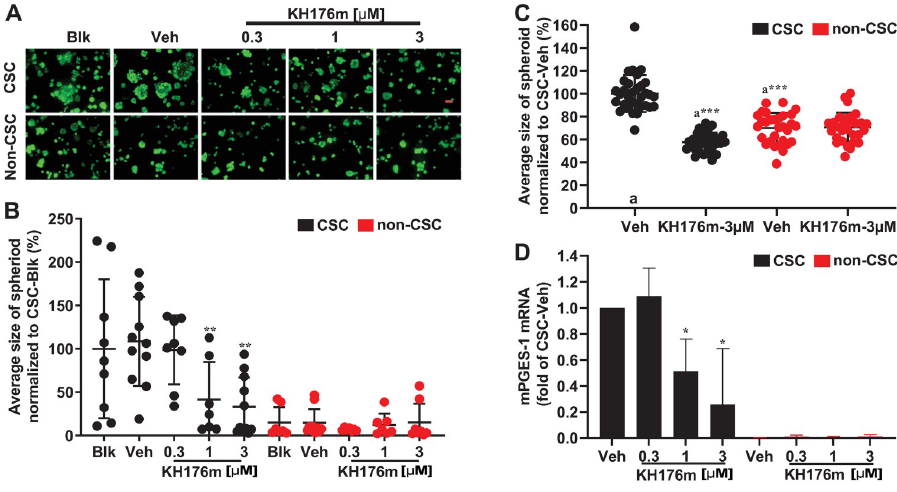
Fig 5. KH176m selectively inhibits mPGES-1 and spheroid growth in prostate cancer stem cells. CSCs or non- CSCs subpopulation were isolated from DU145 human prostate cancer cells based on the cancer stem cell markers CD44-PE and CD24-APC. Both CSCs and non-CSCs subpopulation were grown in Matrigel to induce spheroid formation and treated with vehicle (0.1% DMSO) or various concentrations of KH176m (A) Representative images of spheroids generated by CSCs or non-CSCs (-/+KH176m). Scale bars represent 100 microns; (B) Average spheroid size generated by CSCs or non-CSCs (-/+KH176m). Each data point corresponds to the average size of spheroids from 1 image stack. Data are means ± SD (n = 8–12, from 3 independent biological repeats). (C) Average spheroid size generated by CSCs or non-CSCs (-/+KH176m). Each data point corresponds to the average size of spheroids from 1 image stack. Data are means ± SD (n = 27, from 3 independent biological repeats). (D) Gene expression of mPGES-1 was analyzed by qRT-PCR (n = 3). Blk: Blank; Veh: Vehicle. � , p < 0 . 05; �� , p < 0 . 005 ; significant differences compared with